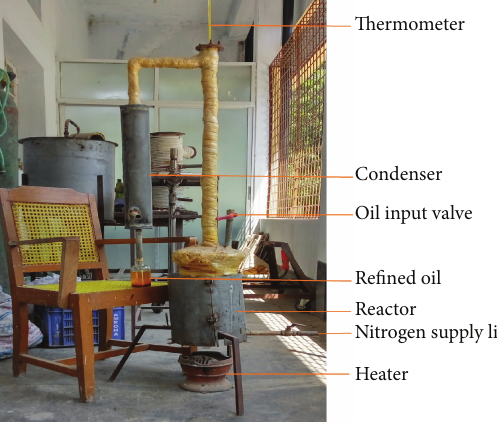
Figure 4: Experimental setup of the distillation